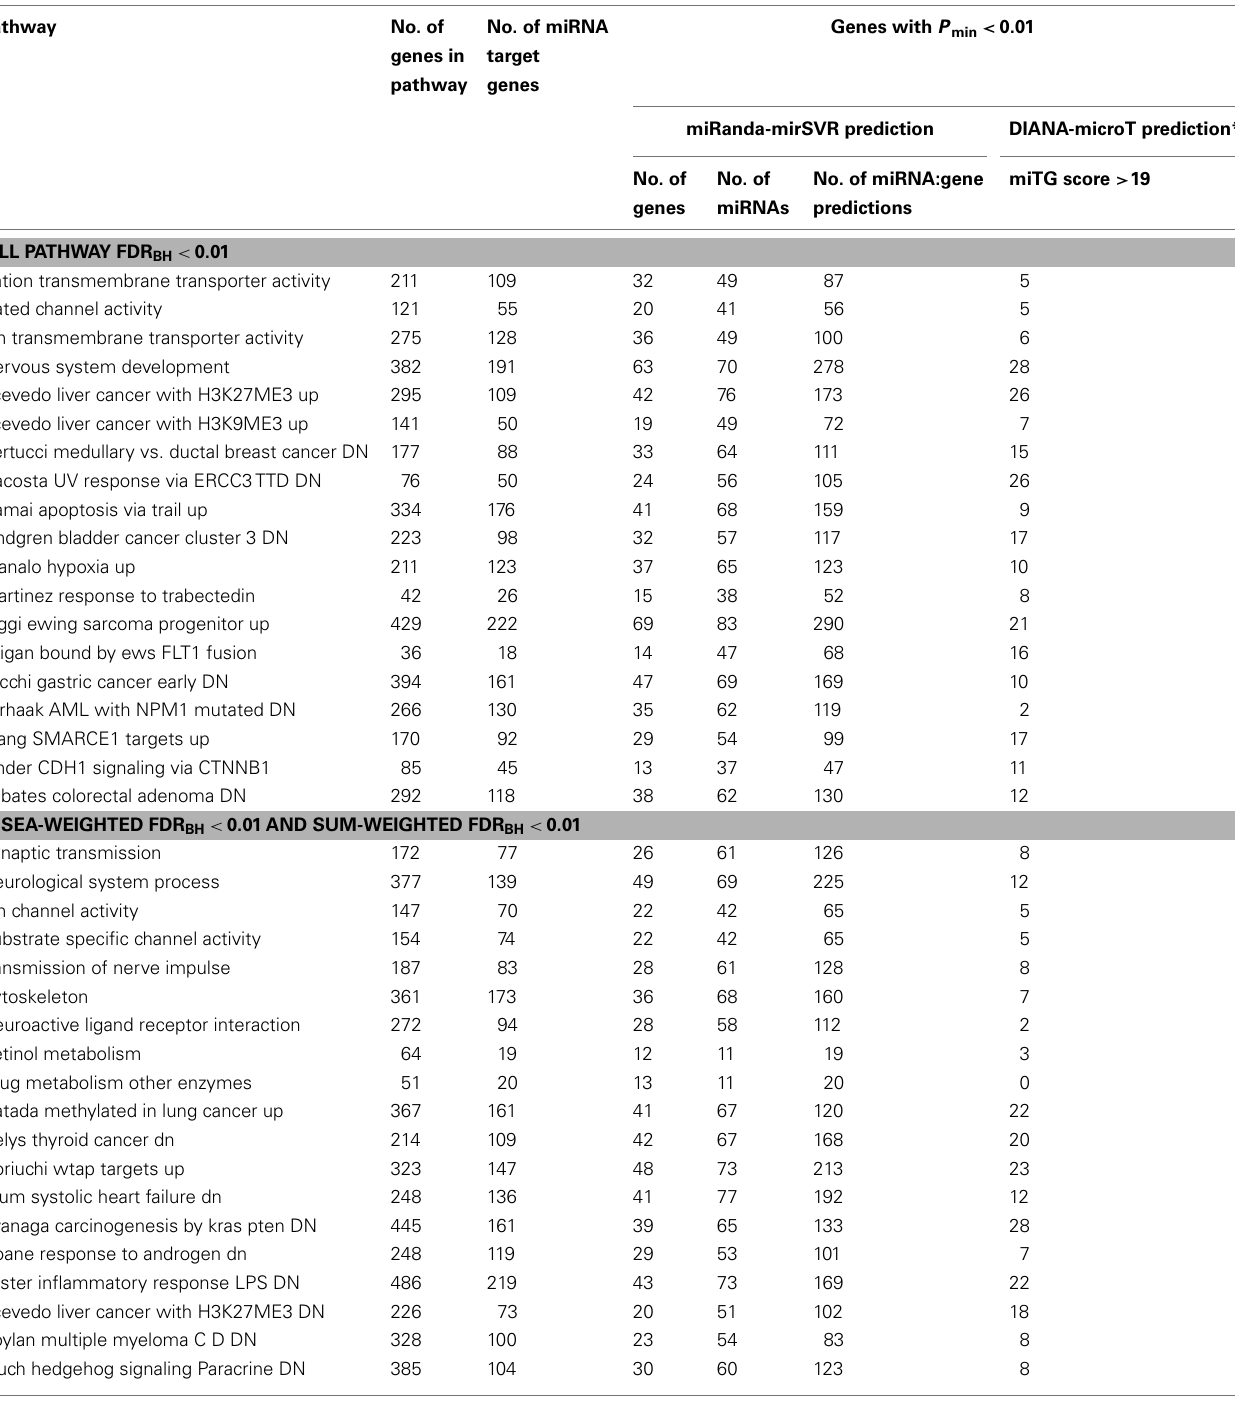
Table 3 | Predictions of psychiatric- and neurological-associated miRNA target genes with P min < 0.01 in 38 significantly enriched pathways. Pathway No. of